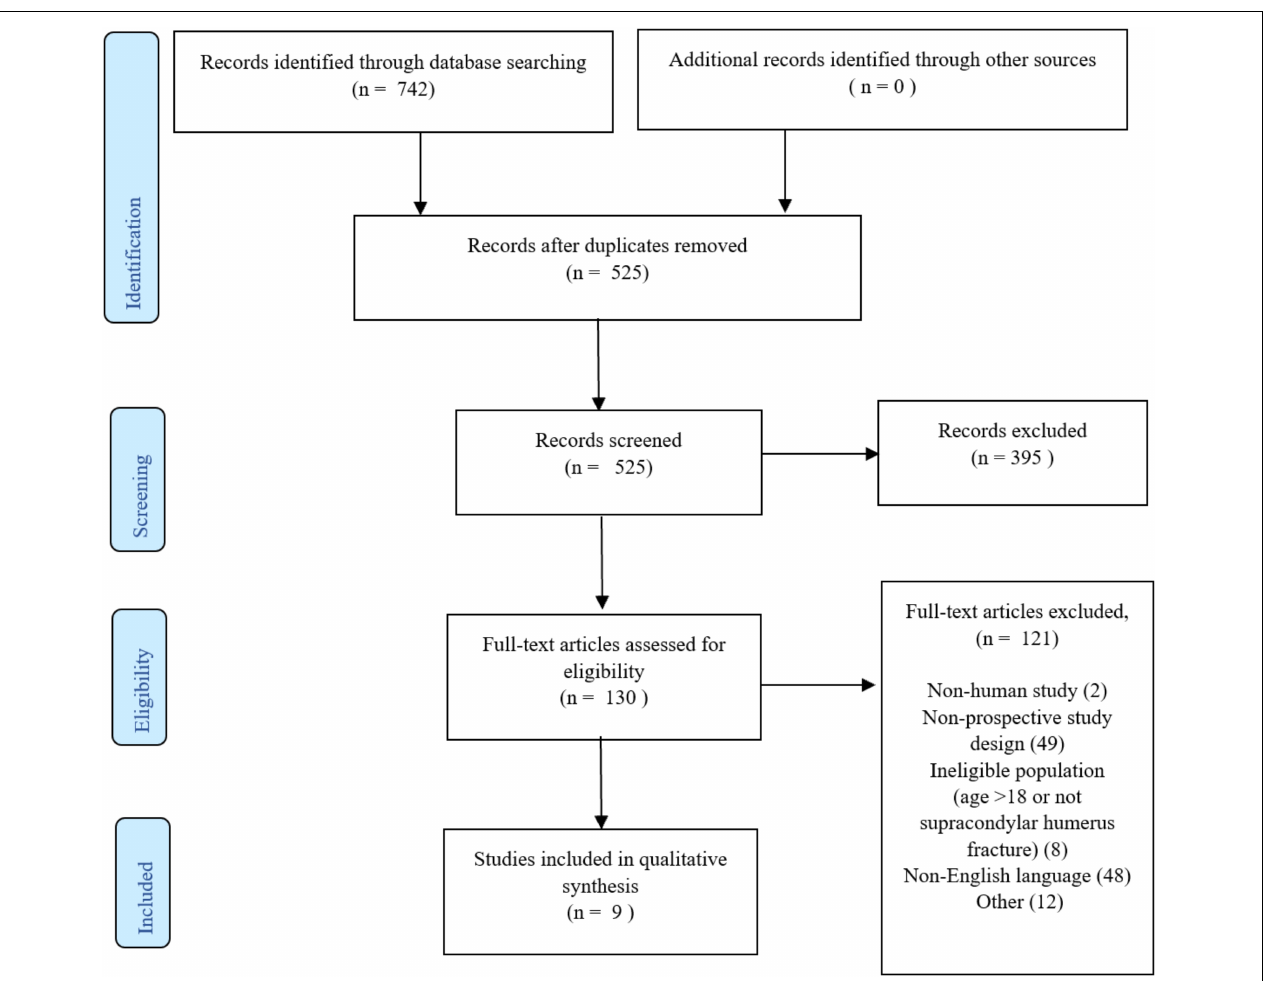
FIGURE 1 | Prisma